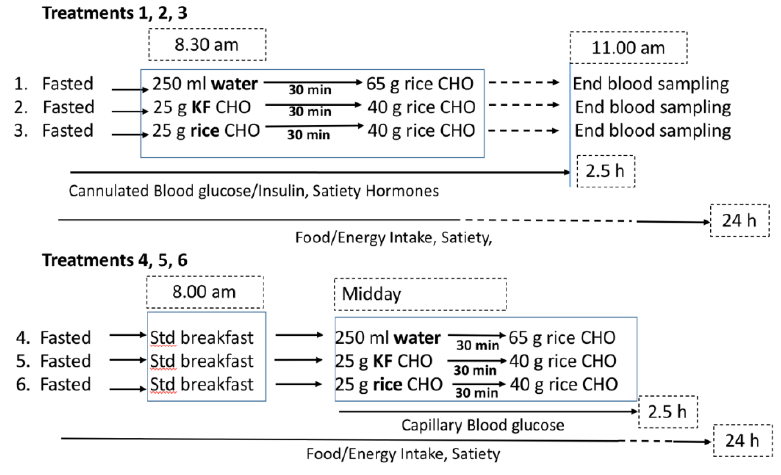
Figure 1. Summary of experimental design. KF = kiwifruit; CHO = carbohydrate, Std breakfast = standard